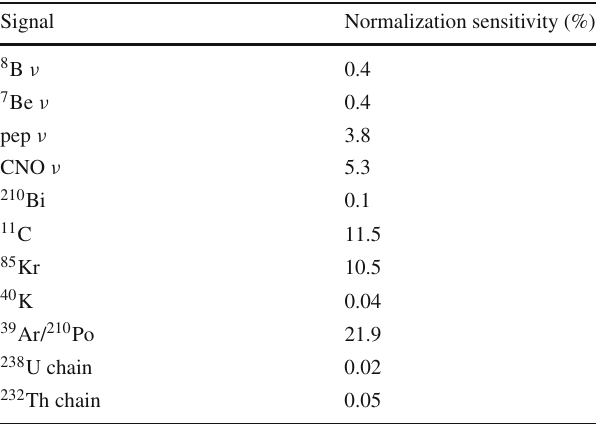
Table 3 Fit uncertainty for 5 years of data with the baseline configu- ration and background assumptions Signal